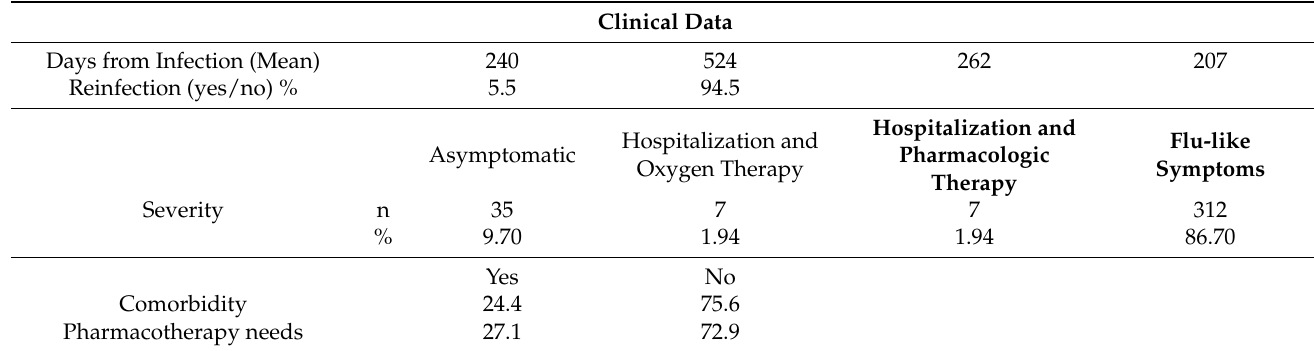
Table 1. Clinical Data of the